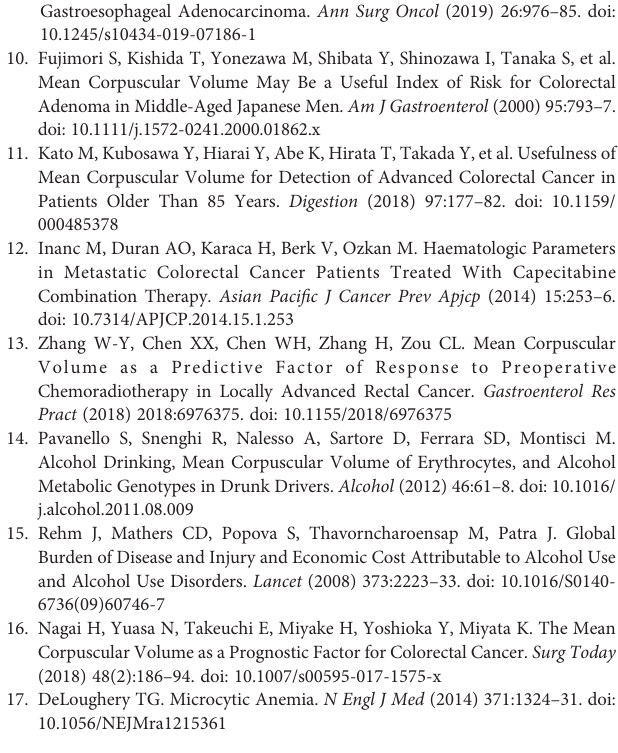
Supplementary Figure 1 | Flow chart of patient inclusion. Supplementary Figure 2 | Kaplan – Meier OS curves according to the levels of pretreatment